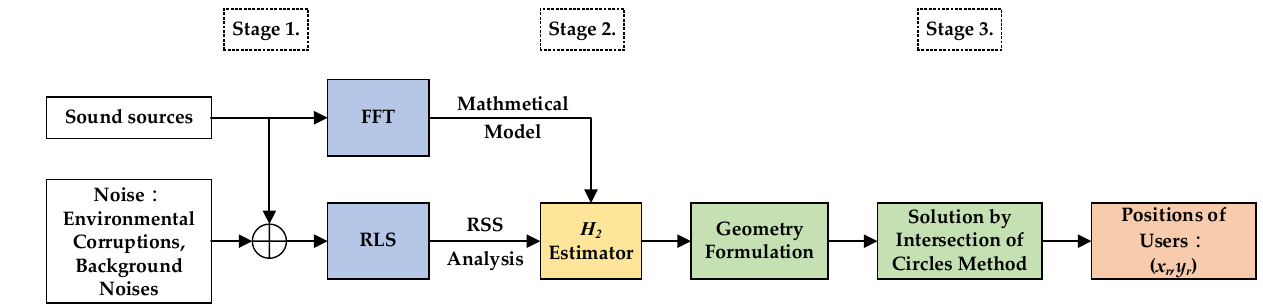
Figure 1. Flow chart of the proposed indoor positioning algorithm.